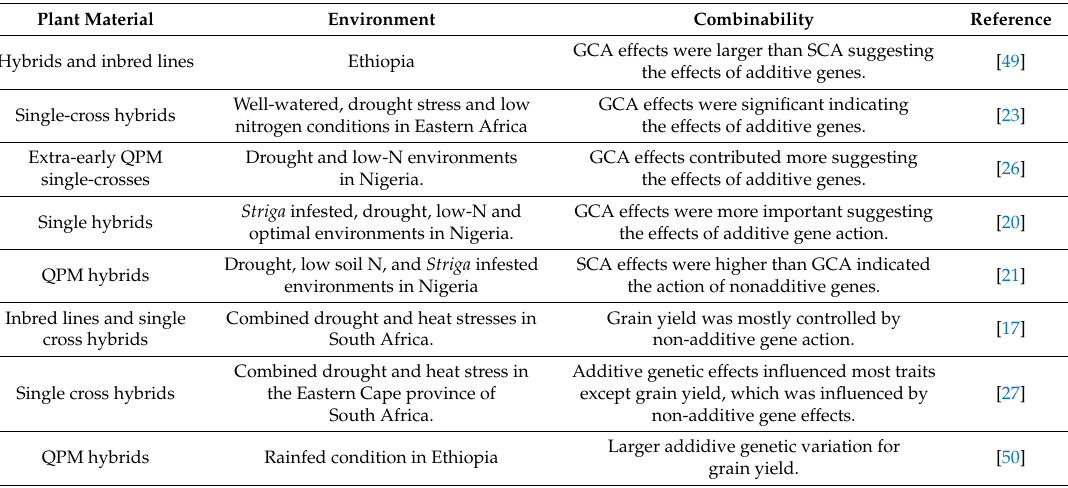
Table 4. Combining ability studies for QPM genotypes evaluated over the